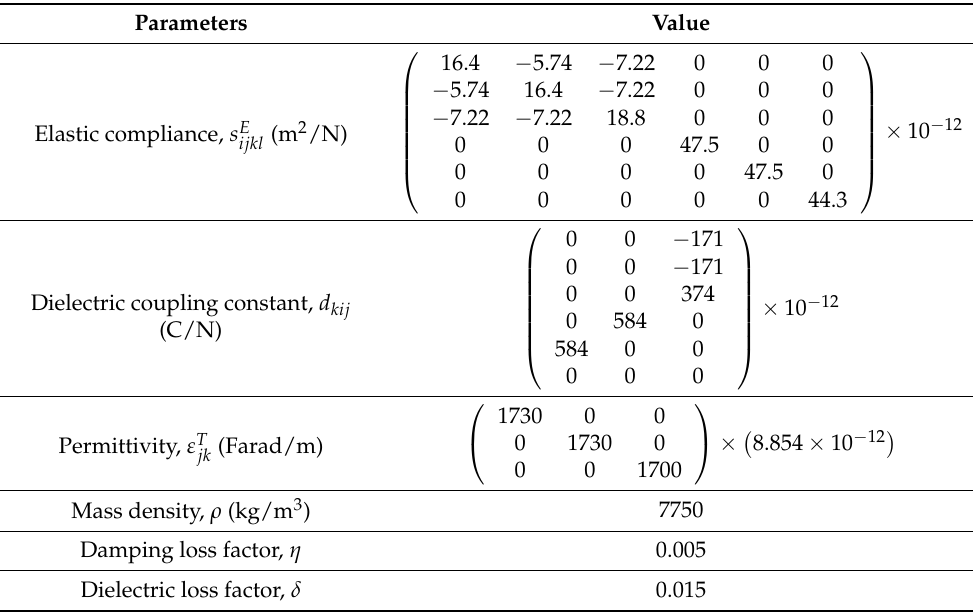
Table 2. Properties of the PZT-5A patch [35].